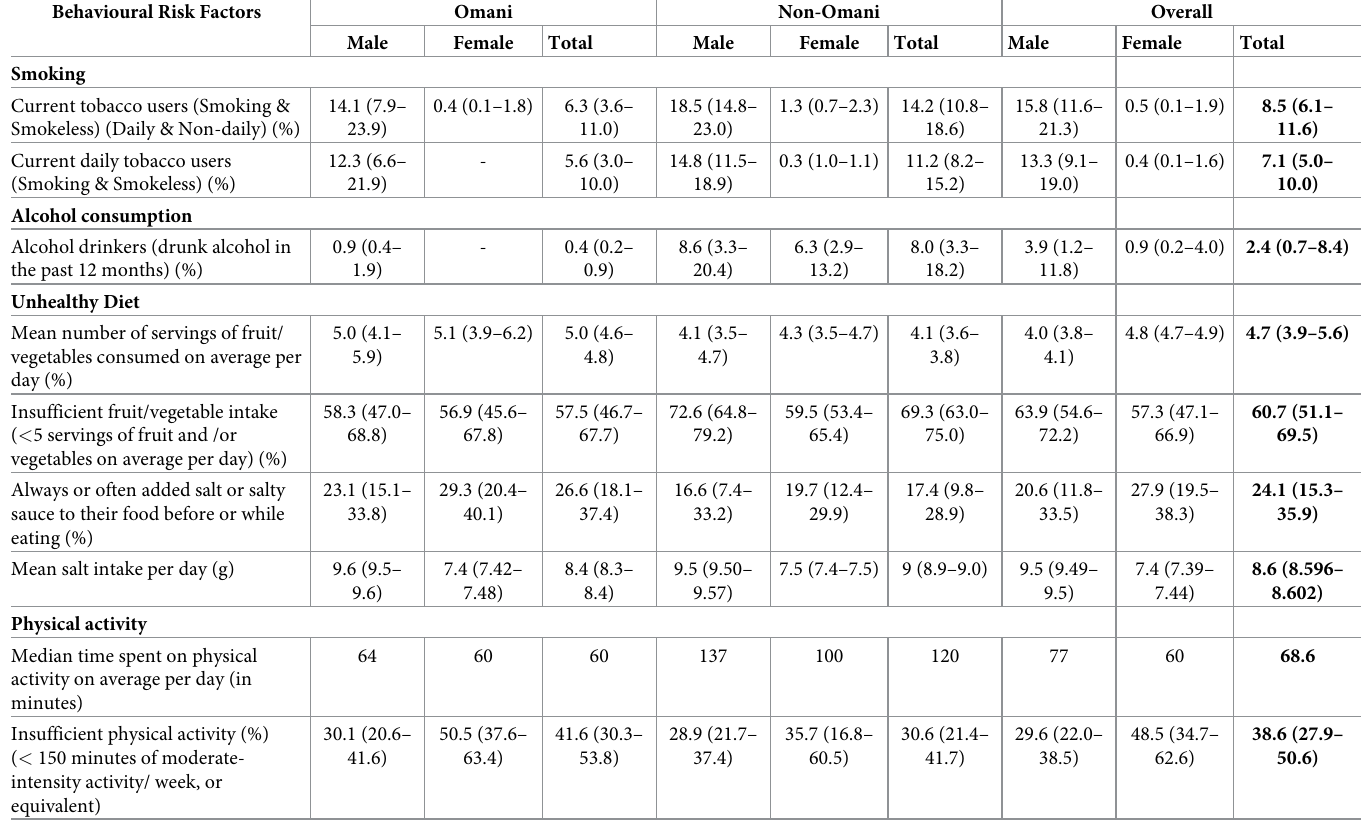
Table 2. Prevalence of behavioural risk factors of non-communicable diseases among the survey participants. Behavioural Risk